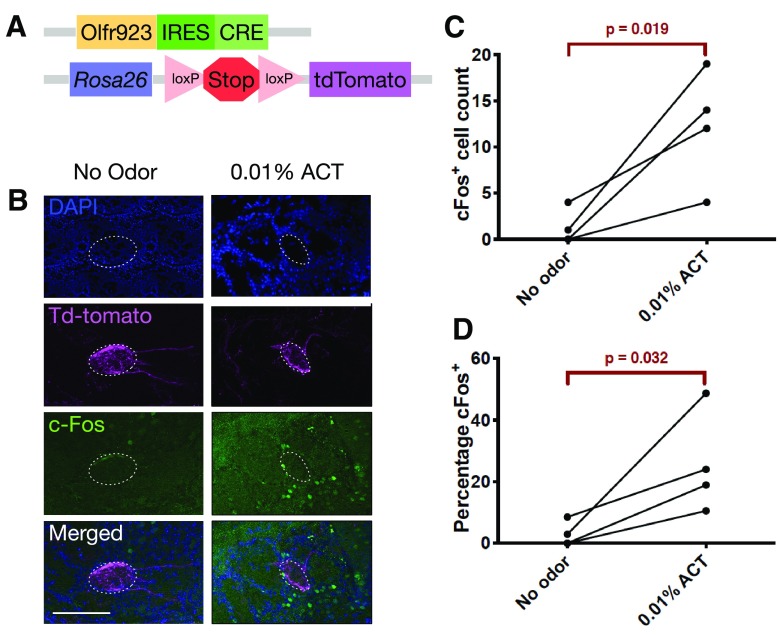
Exposure to 0.01% starting concentration of ACT induces c-Fos expression in Olfr923 periglomerular neurons. A, Schematic drawing of the Olfr923-Cre transgenic mouse targeting vector. B, Fluorescence microscopy image showing the Olfr923 mouse glomerulus. Magenta is Olfr923 labeled by td-tomato, green is periglomerular neurons stained for c-Fos, blue is DAPI nuclear staining. Scale bar: 100 μm. Tissue sections with the greatest density of td-tomato fibers at the glomeruli were used for staining. C, c-Fos-positive periglomerular cell counts around the Olfr923 glomeruli. D, Percentage of c-Fos-positive periglomerular cells, calculated by the number of c-Fos-positive over the total number of DAPI-labeled Olfr923 periglomerular cells. C, p values are based on paired t test, one-tailed (no odor compared with 0.01% ACT). N = 4 mice were used for each odorant condition. Dots connected with a horizontal line represent samples that were stained on the same day. See Extended Data Figures 6-1, 6-2 for the detailed targeting vector construct and additional staining images at the Olfr923 glomeruli.